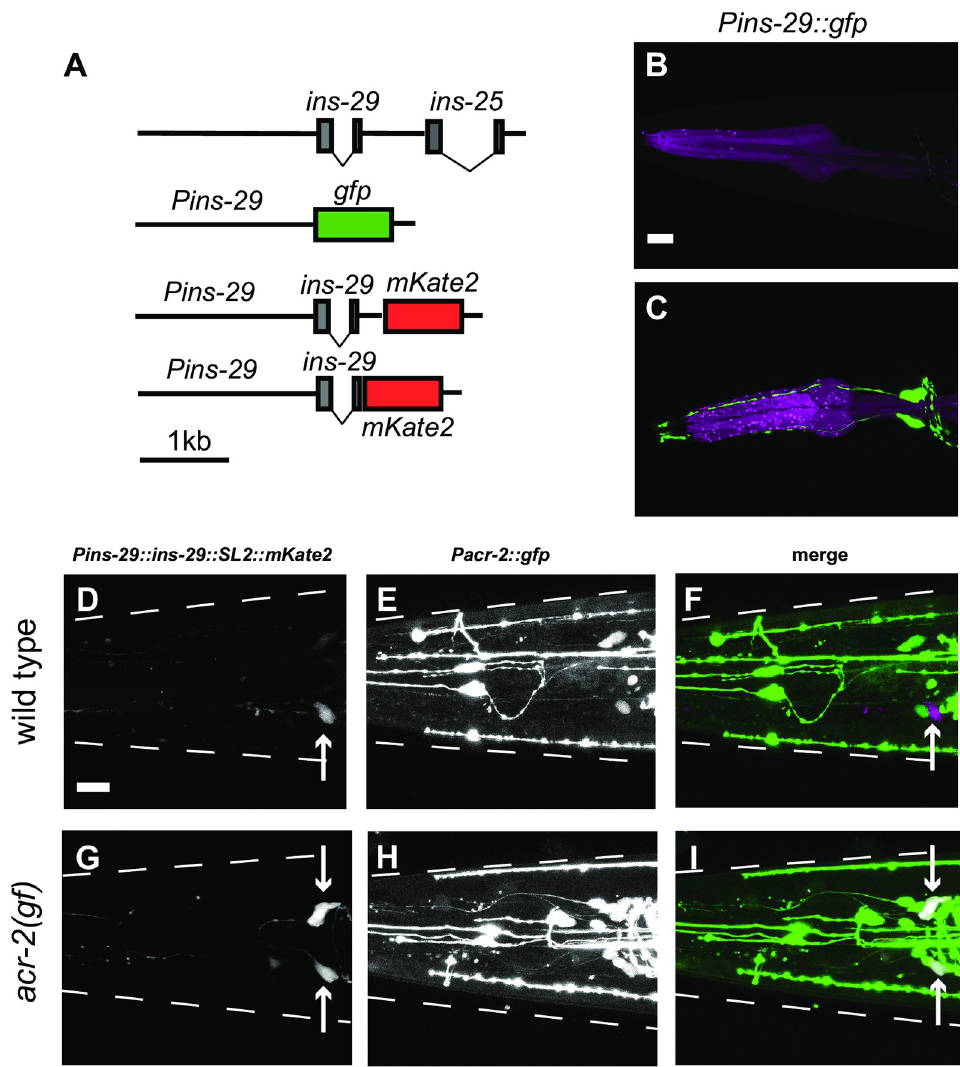
Fig 3. Expression of ILP genes and acr-2 is up-regulated in two head neurons in acr-2(gf) animals. A. Shown is the gene structure of ins-29 and ins-25 loci. Also shown are diagrams of the ins-29 transcription reporters and expression constructs used in this study (Listed in S1 Table). Two ins-29 expression constructs were made, one that contained SL2:: mKate2 sequence to monitor transgene expression, the other has mKate2 in-frame fused to INS-29, without the SL2 trans-splice sequence. B-C. Pins-29 :: gfp is expressed in two head neurons in acr-2(gf) . scale bar:10 μ m. (B) in wild-type Pins-29 :: gfp(juEx7742) is often detected in one or zero cells in the head. (C) In acr-2(gf) , Pins-29 :: gfp is strongly expressed in two head neurons. D-I. A Pins-29 :: ins-29 :: SL2 ::mKate2 reporter (juEx7966) co-localizes with Pacr-2 :: gfp(juIs14) expression in acr-2(gf ) animals, but not in wild type. scale bar:10 μ m. Cell bodies expressing mKate2 are labeled by an arrow. (D) In wild type animals, Pins-29 :: ins-29 :: SL2 ::mKate2( juEx7966 ) is weakly or not expressed in the head. Shown is an animal expressing the transgene in a single neuron. (E) Pacr-2 :: gfp is expressed in multiple neurons in the head of wild type animals. (F) Expression of ins-29 and acr-2 transcriptional reporters do not overlap in wild type animals, suggesting that acr-2 is not normally expressed in the same neurons as ins-29 in wild type. (G) Expression of Pins-29 :: ins-29 :: SL2 :: mKate2 in acr-2(gf) is similar to that of Pins-29 :: gfp observed in (C). (H) Expression of Pacr-2 :: gfp reporter in acr-2(gf) animals. (I) Co-localization is observed between the ins-29 reporter and Pacr-2 :: gfp in acr-2(gf ) animals. In all images, animals are rolled ventral-side up for easy visualization of neuron pairs. The dashed lines represent the approximate outline of the animal. The two processes in the head of animals expressing the Pins-29 :: ins-29 :: SL2 :: mKate2 are mechanosensory neuron dendrites labeled by the Pmec-4 :: gfp co-injection marker. Beading observed in some images (i.e. the Pacr-2 :: gfp in E, H) is due to rolling the animals in 10% agarose.